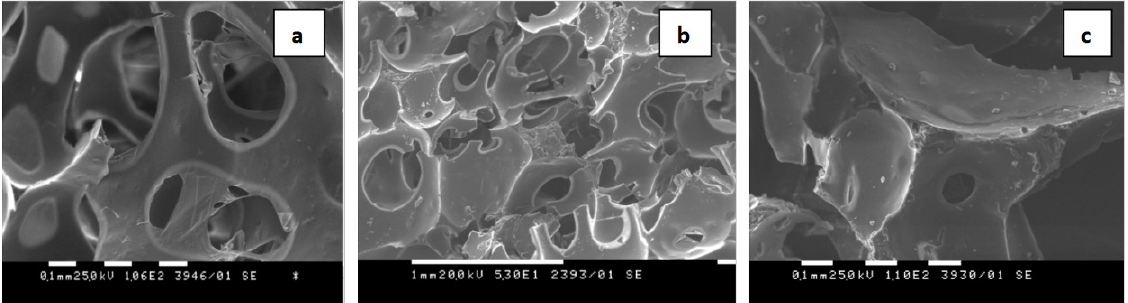
Figure 5. SEM of the PU (a), PU/10BG (b) and PU/20BG (c) before in vitro